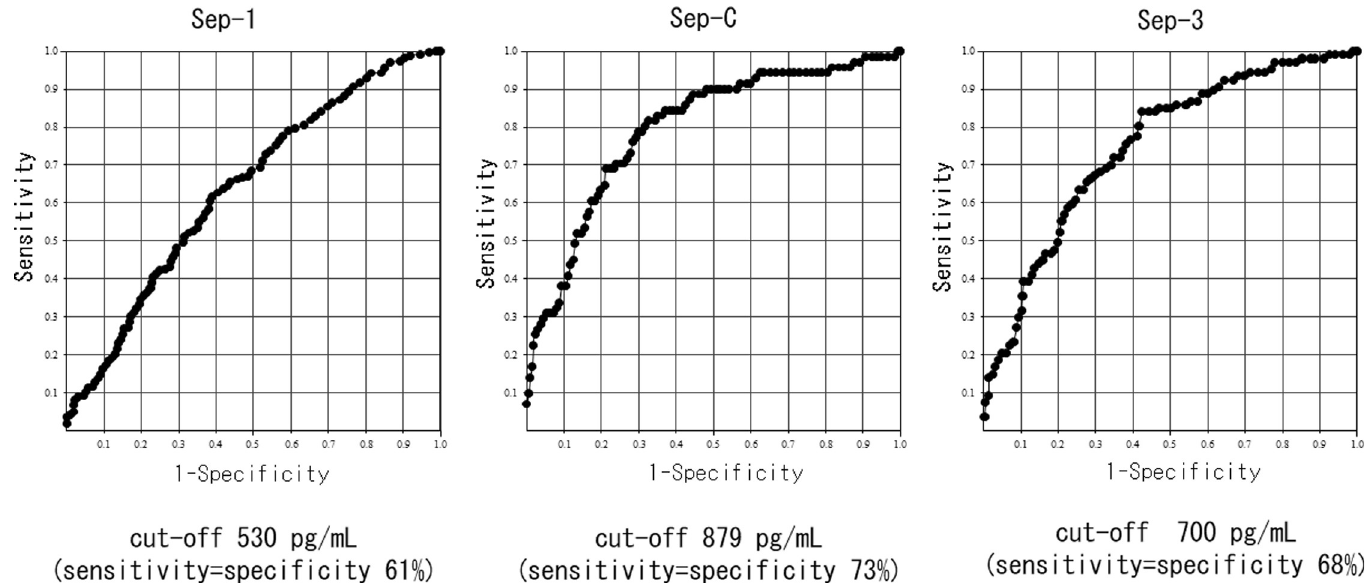
Fig 7. Receiver operator characteristic curve of Pre for each sepsis diagnosis[All subjects with infectious diseases(N = 595)]. AUC: area under the curve. AUCs were as follows:.Sep-1: AUC = 0.64 ± 0.02; Sep-C: AUC = 0.80 ± 0.03; Sep-3: AUC = 0.75 ± 0.03.